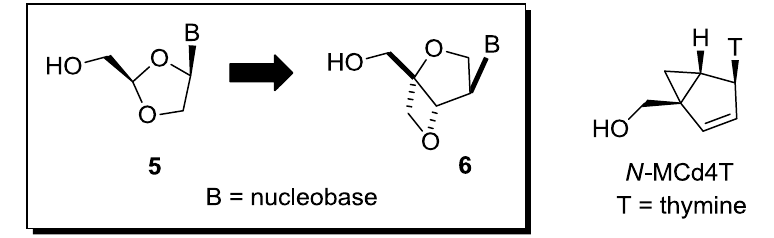
Figure 3. Design of nucleoside derivative built on a 2,6-bicyclo[3.2.0]heptane